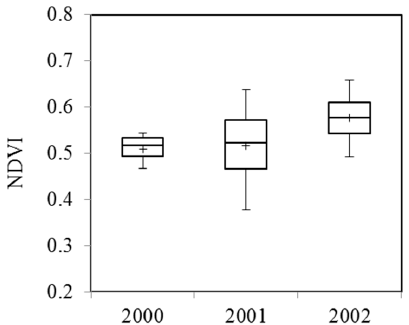
Figure 4 . Normalized difference vegetation index (NDVI) values of the highest 20% pixel candidates for a cold pixel selected from four images per each year. Each plot shows the minimum, maximum, average and first, second and third